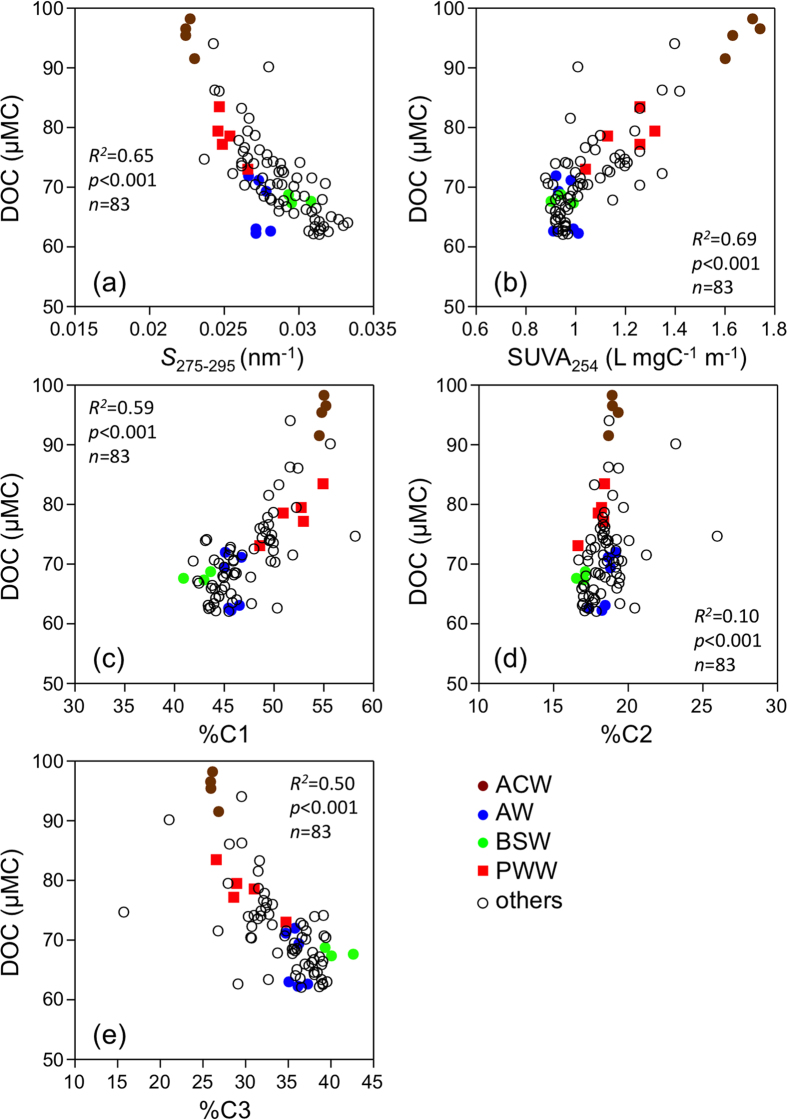
Property-property plots between DOC concentration and (a) S275–295, (b) SUVA254, (c) %C1, (d) %C2, and (e) %C3.